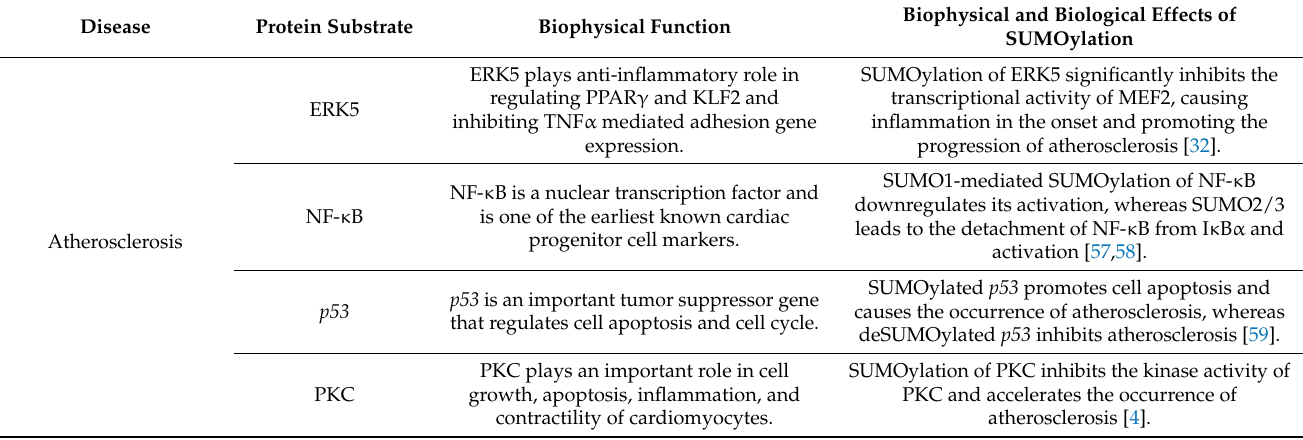
Table 2. The roles of SUMOylation of substrates in